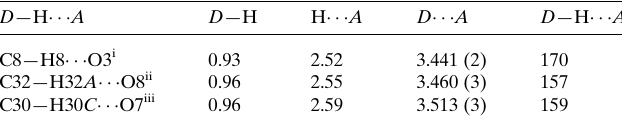
Table 1 Hydrogen-bond geometry (A˚ , (cid:5) ).